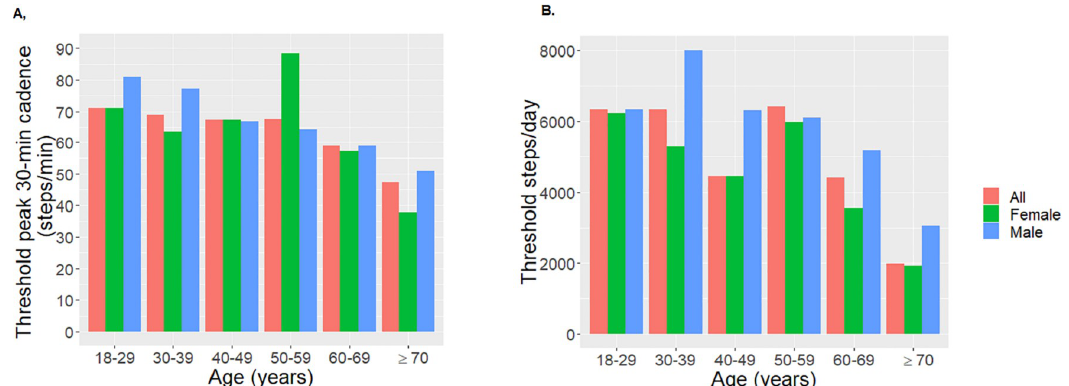
Fig 1. Sex-specific and total population thresholds for metabolic syndrome determined for each age decade. Higher thresholds indicate higher steps/min or more steps/day are required to achieve positive health outcomes. A. Thresholds for peak 30-min cadence B. Thresholds for steps/day.